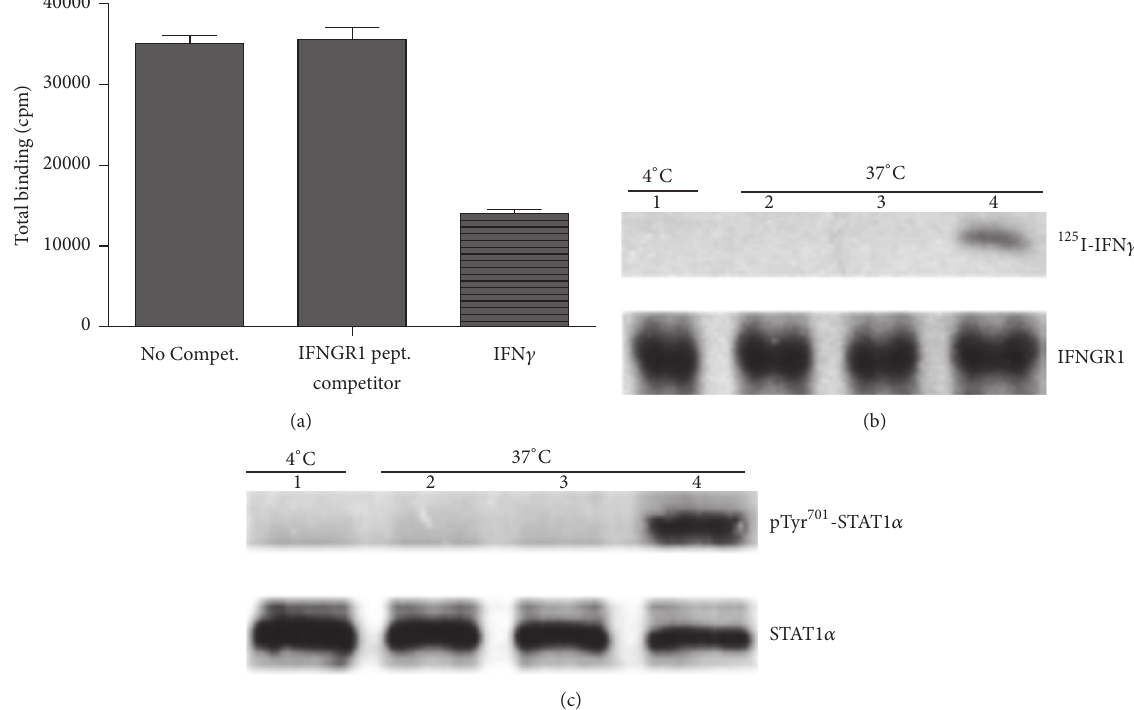
Figure 2: Intracellular presence of peptide IFNGR-1(253-287) inhibits binding to IFNGR of extracellular IFN 𝛾 and subsequent activation of STAT1 𝛼 . (a) Presence of extracellular peptide IFNGR-1(253-287) did not inhibit binding of 125 I-IFN 𝛾 to P388D1 cells at the concentrations to be used in subsequent experiments. Unlabeled murine IFN 𝛾 or peptide IFNGR-1(253-287), as indicated, was added at a final concentration of 1 𝜇 M to P388D1 cells at 4 ∘ C along with 10 nM of 125 I-IFN 𝛾 , and cells were incubated at 4 ∘ C for 30 minutes. Control cells were incubated with 125 I-IFN 𝛾 in the absence of any competitor. Cells were then washed and bound IFN 𝛾 determined. Samples were run in triplicate and values plotted as mean ± s.d. (b) Intracellular accumulation of peptide IFNGR-1(253-287) in P388D1 cells by pinocytosis was accomplished by incubating cells with either 25 𝜇 M (lane 2) or 50 𝜇 M (lane 3) of peptide at 37 ∘ C for 1 hour. Cells used in lanes 1 and 4 did not receive any peptide. Cells were then washed at room temperature to remove extracellular peptide and then incubated with 125 I-IFN 𝛾 (10nM) along with 1 𝜇 M of IFNGR-1 peptide for 5 minutes at 37 ∘ C. Control cells (lane 1) were washed in ice-cold medium and then incubated with 125 I-IFN 𝛾 at 4 ∘ C without peptide. After 125 I-IFN 𝛾 incubation, all cells were washed at 4 ∘ C and then acid-washed at 4 ∘ C to remove surface-bound 125 I-IFN 𝛾 . Cells were then lysed and immunoprecipitated with antibodies to IFNGR-1. After Western transfer of immunoprecipitates to nitrocellulose membranes, 125 I-IFN 𝛾 associated with IFNGR-1 was detected by autoradiography. Total IFNGR-1 immunoprecipitated was followed by immunodetection with IFNGR-1 antibodies (lower panel). (c) Conditions are the same as in (b), except that lysates were immunoprecipitated with STAT1 𝛼 antibodies and tyrosine phosphorylation of immunoprecipitated STAT1 𝛼 was followed by immunodetection with antibodies specific for Tyr701-phosphorylated STAT1 𝛼 . Total immunoprecipitated STAT1 𝛼 was followed by reprobing blots with antibodies to STAT1 𝛼 (lower